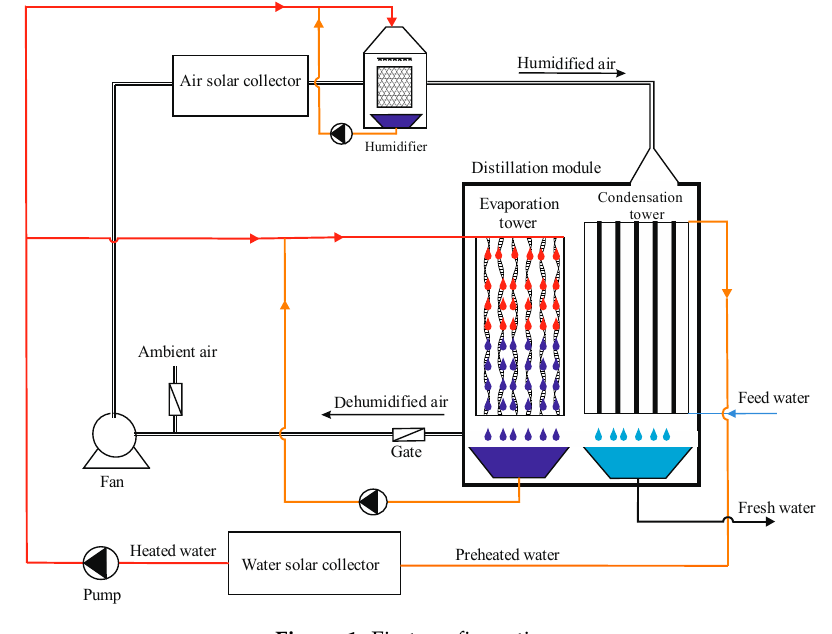
Figure 1. First c onfiguration.